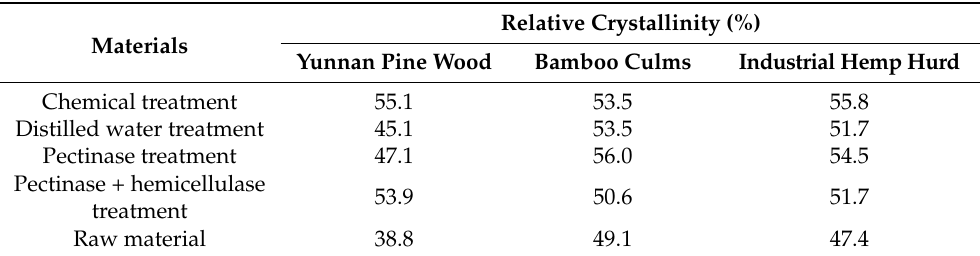
Table 4. Effect of chemical or enzymatic treatment on relative crystallinity of Yunnan pine wood, bamboo culms, and industrial hemp hurd fibers a .